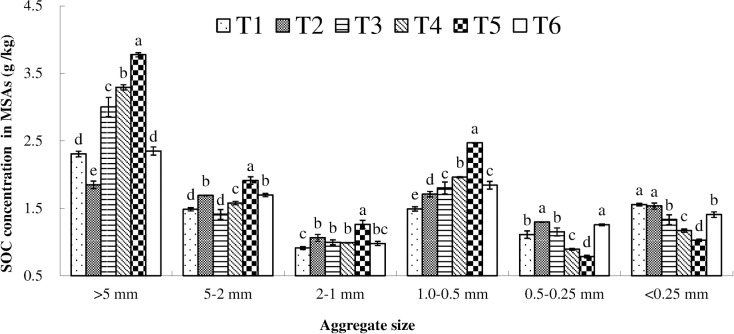
SOC concentration in MSAs under different treatments.Soil samples were collected at a depth of 0–20 cm after two years combined application of biogas slurry (BS) plus chemical fertilizer (CF). SOC: soil organic carbon (g/kg); MSAs: mechanical—stable aggregates. T1: control (no BS or CF); T2: CF only; T3: 15% BS—TN plus 85% CF—TN, T4: 30% BS—TN plus 70% CF—TN; T5: 45% BS—TN plus 55% CF—TN; and T6: BS only. Values were mean (n = 3). vertical bars in the figures represent the standard deviation of mean (n = 3) and lower case letters indicate significant differences between treatments at the P < 0.05 level (LSD test). ANOVA source information is shown in S5 Table.